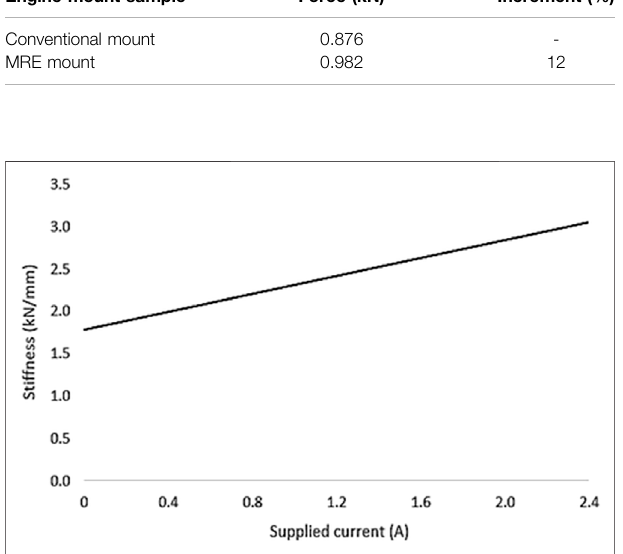
FIGURE 11 | On-state static stiffness of the MRE engine